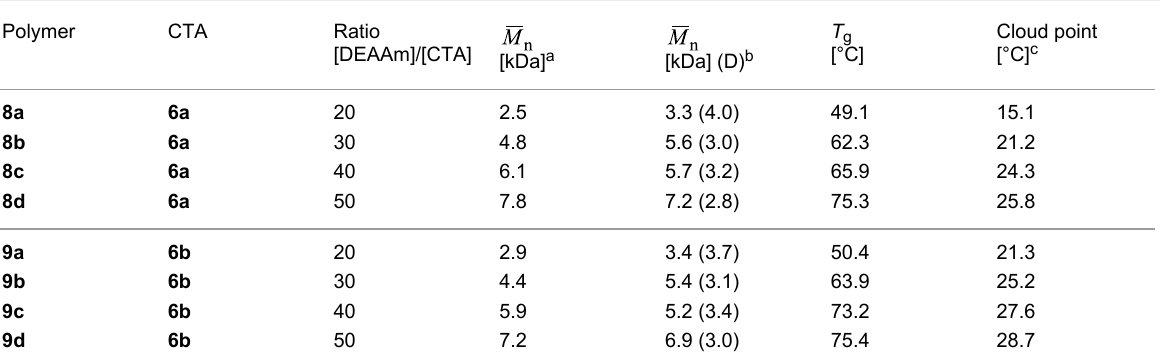
Table 1: Number average molecular weights ( ), dispersity (D), glass transition temperatures ( T g ) and cloud points of the end-group-functionalized polymers ( 8a–d and 9a–d